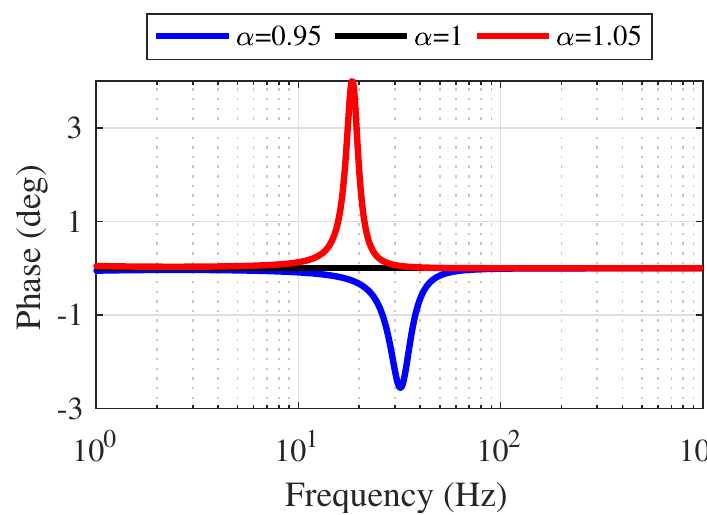
Figure 34. Phase–frequency characteristics of